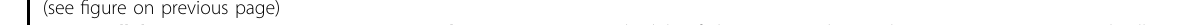
Fig. 2 Cellular immune responses in vaccinated C57BL/6 mice. a Schedule of chimpanzee adenoviral vaccine immunization and cell sorting strategies in female C57BL/6 mice (6 – 8-week-old). Eight groups ( n = 6) of C57BL/6 mice were i.m. injected with 2 × 10 10 vp viruses. Splenocytes were collected on day 10 post priming and boosting immunization, respectively. b ELISpot assay was performed to measure the IFN- γ secretion of splenocytes after S1 peptide pool stimulation in vaccine-immunized mice. Cells were harvested on day 10 post vaccination. c – e Percentage of CD8 + cytotoxic T lymphocytes expressing IFN- γ , TNF- α , and IL-2 in response to the S1 peptide pool on day 10 post immunization. f – h Percentage of CD4 + helper T cells expressing IFN- γ , TNF- α , and IL-2 in response to the S1 peptide pool on day 10 post immunization. i – k Percentage of CD4 + helper T cells expressing IL-4, IL-5, and IL-13 in response to the S1 peptide pool on day 10 post immunization. All data were shown as means ± SEM. P- values were analyzed with one-way ANOVA ( ns P ≥ 0.05; * P < 0.05; ** P < 0.01; *** P < 0.001; **** P <